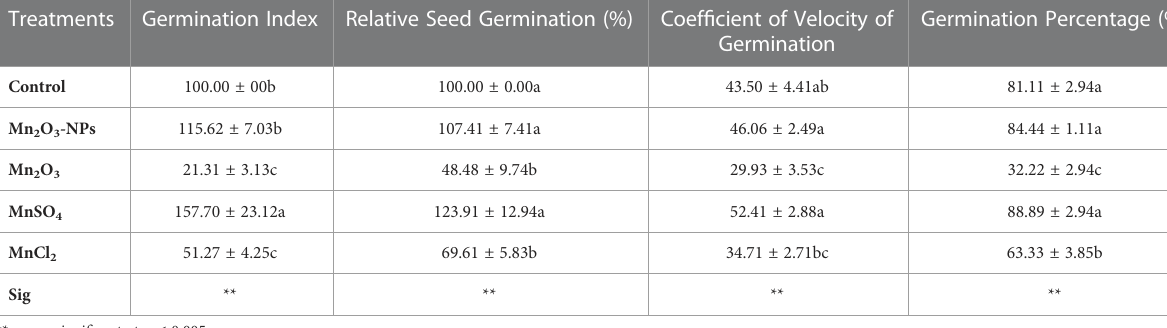
TABLE 1 Germination-related parameters of A.annua seeds primed with different Mn species. Treatments